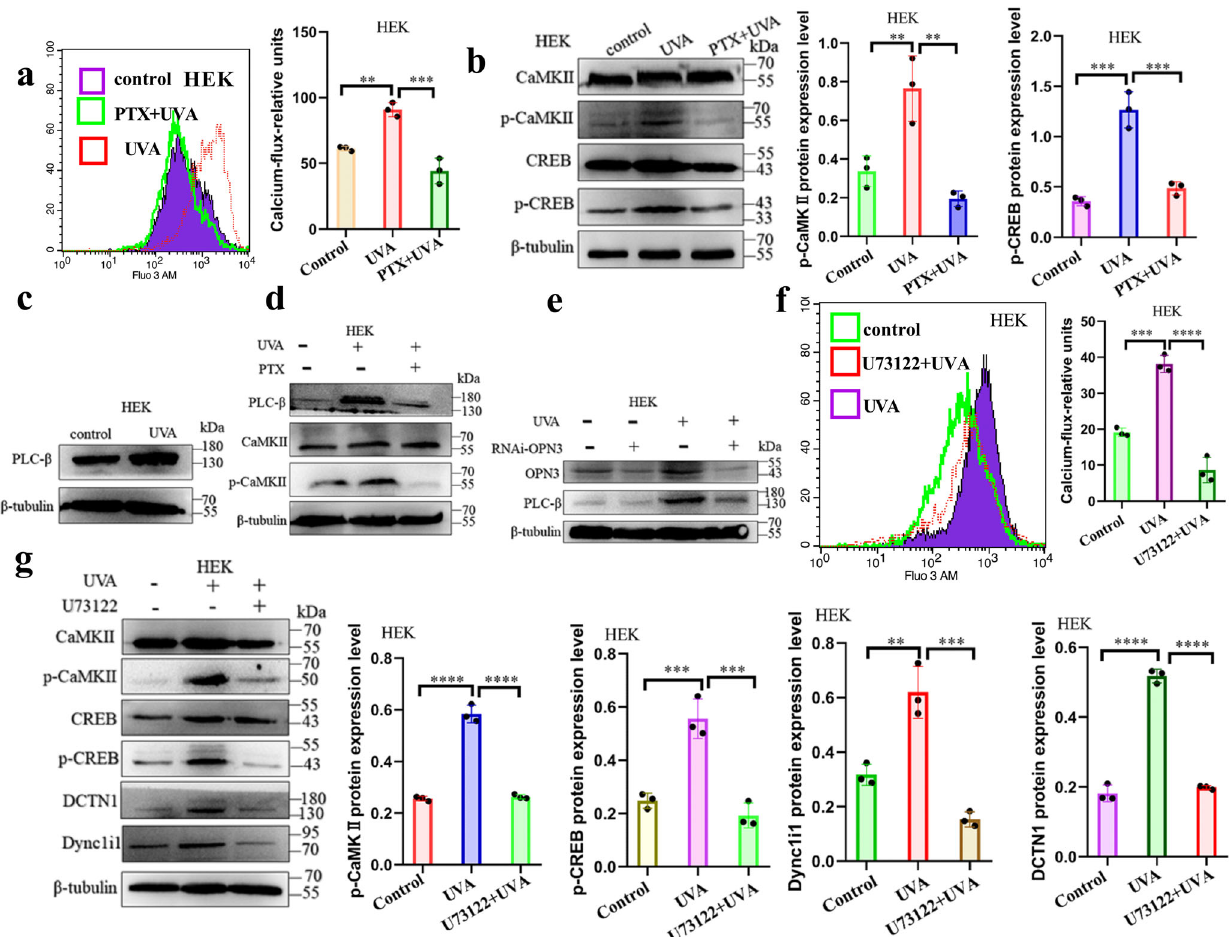
Fig. 6 OPN3 mediates melanin cap formation via the PLC- β signaling pathway. a HEK treated with PTX was stimulated with 3 J cm − 2 UVA, and calcium fl ux was quanti fi ed by fl ow cytometry. n = 3 independent experiments. Statistical signi fi cance was determined by one-ANOVA with post-test. ** P < 0.01, *** P < 0.001. b HEK treated with PTX were stimulated with 3 J cm − 2 UVA, and p-CaMKII and p-CREB protein expression level was analyzed by WB. WB analyses were normalized using β -tubulin as a loading control, and the relative protein level was quanti fi ed using Quantity One software. Statistical signi fi cance was determined by one-ANOVA with post-test. ** P < 0.01, *** P < 0.001. c HEK were irradiated without and with UVA, and PLC- β protein levels were determined by WB. d HEK treated with PTX were stimulated with 3 J cm − 2 UVA; protein level was analyzed by WB. e HEK were transfected with siRNA against OPN3 irradiated with UVA and lysed after 1 h. Lysates were analyzed by WB using the indicated antibodies (anti-OPN3 and anti-PLC- β ). β -tubulin was used as a loading control. f HEK treated with U73122 were stimulated with 3 J cm − 2 UVA; calcium fl ux was quanti fi ed by fl ow cytometry. n = 3 independent experiments. Statistical signi fi cance was determined by one-ANOVA with post-test. *** P < 0.001, **** P < 0.0001. g HEK treated with U73122 were stimulated with 3 J cm − 2 UVA; p-CaMKII, p-CREB, DCTN1, and Dync1i1 protein expression level was analyzed by WB. WB analyses were normalized using β -tubulin as a loading control, and the relative protein level was quanti fi ed using Quantity One software. Statistical signi fi cance was determined by one-ANOVA with post-test. ** P < 0.01, *** P < 0.001, **** P <